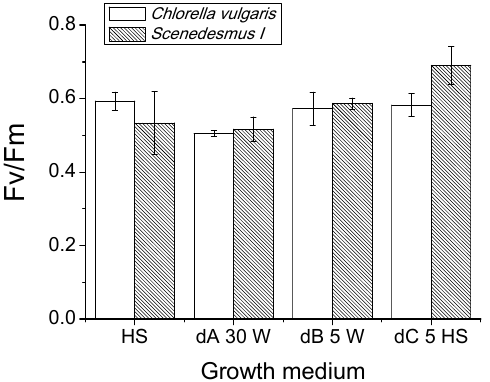
Figure 3. Fv/Fm of algae cultures at the different growth conditions at the end of the exponential phase. Proteins, Lipids and Pigment Accumulation in Photobioreactor Cultivation